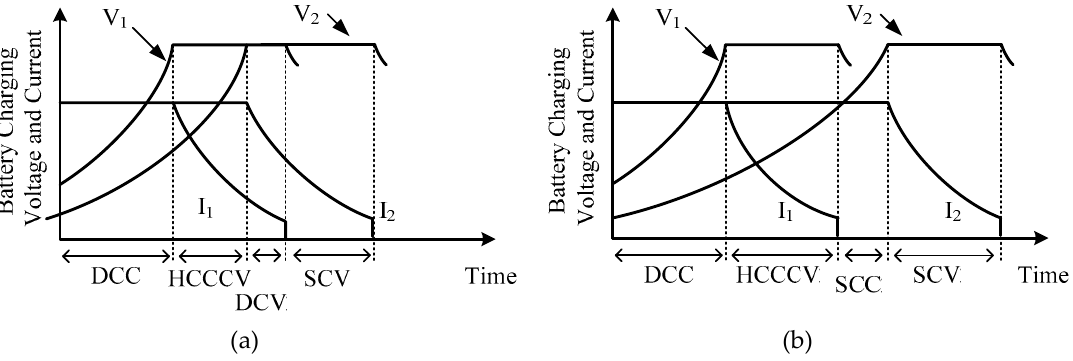
Figure 8. Two possible charging profiles for the proposed converter with ( a ) small difference of SoC, ( b ) large difference of SoC.